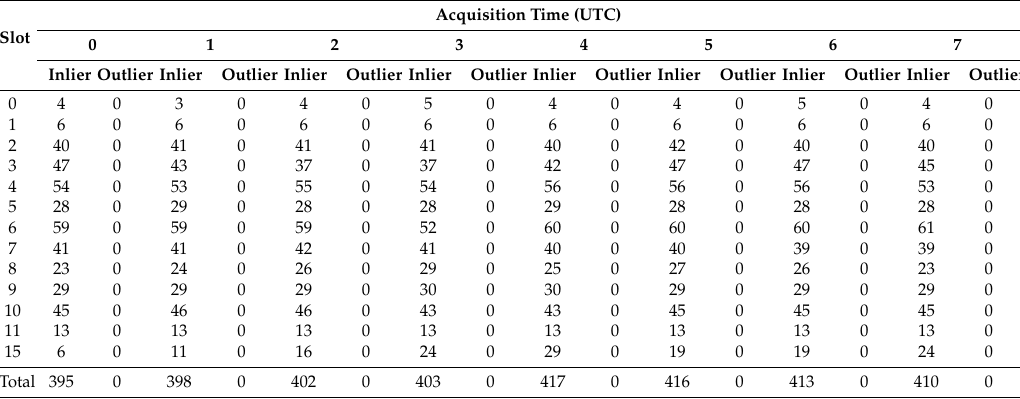
Table 3. Shoreline-matching result (after